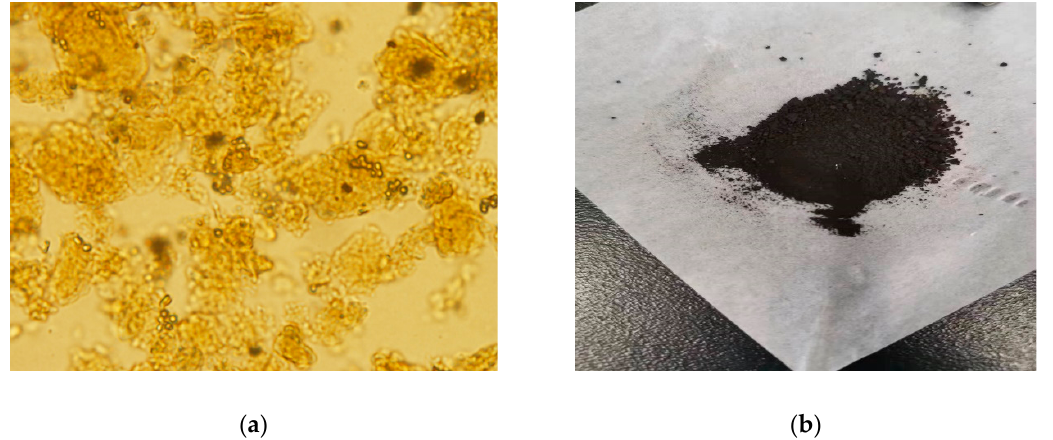
Figure 1. Optical microscopy photograph (500×) of magnetic yeast (MY) ( a ); actual size photograph of MY ( b ).